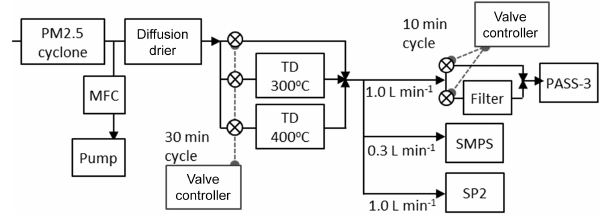
Figure 1. Flow diagram of a measurement system for dried parti- cles that did and did not pass through the thermodenuders (TDs) maintained at 300 and 400 ◦ C using the PASS-3, SMPS, and SP2. Black arrow lines indicate the flow lines of sample